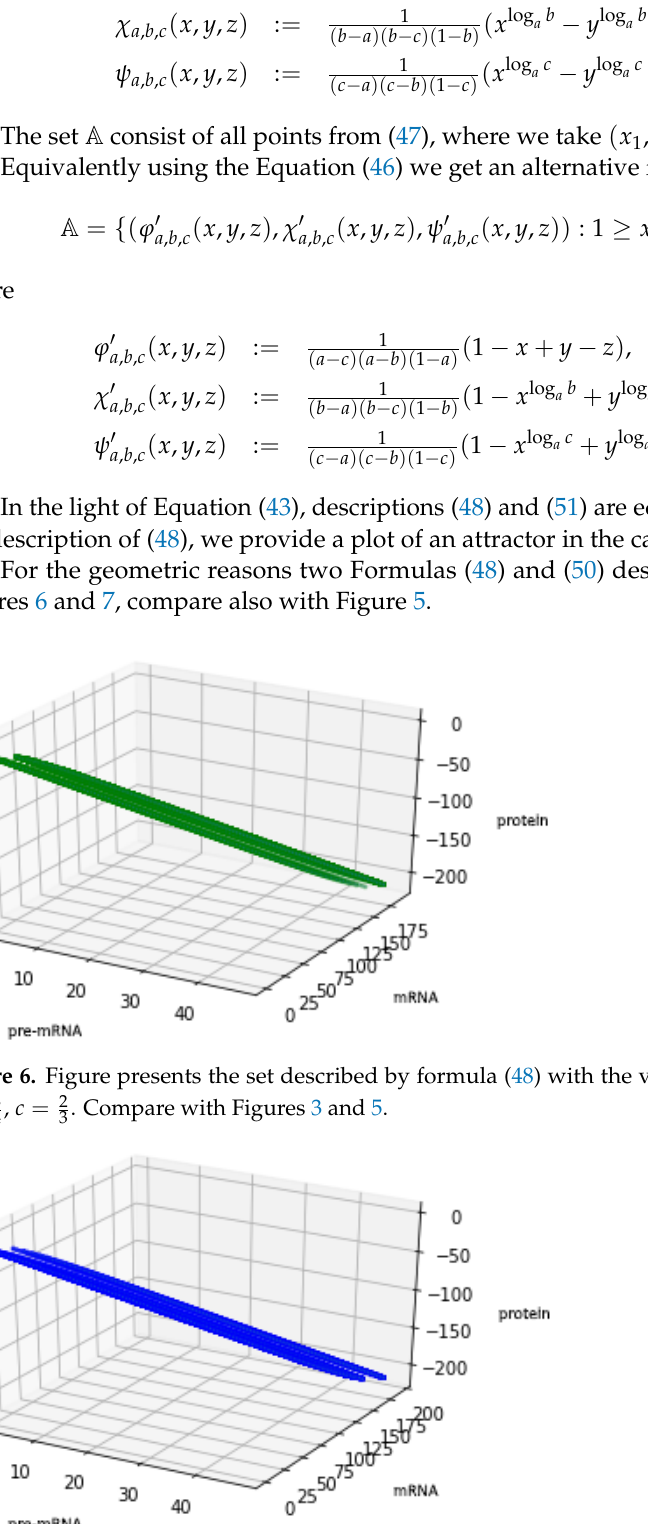
Figure 7. Figure presents the set described by Formula (50) with the values of parameters: a = 1 b = 3 , c = 2 3 4